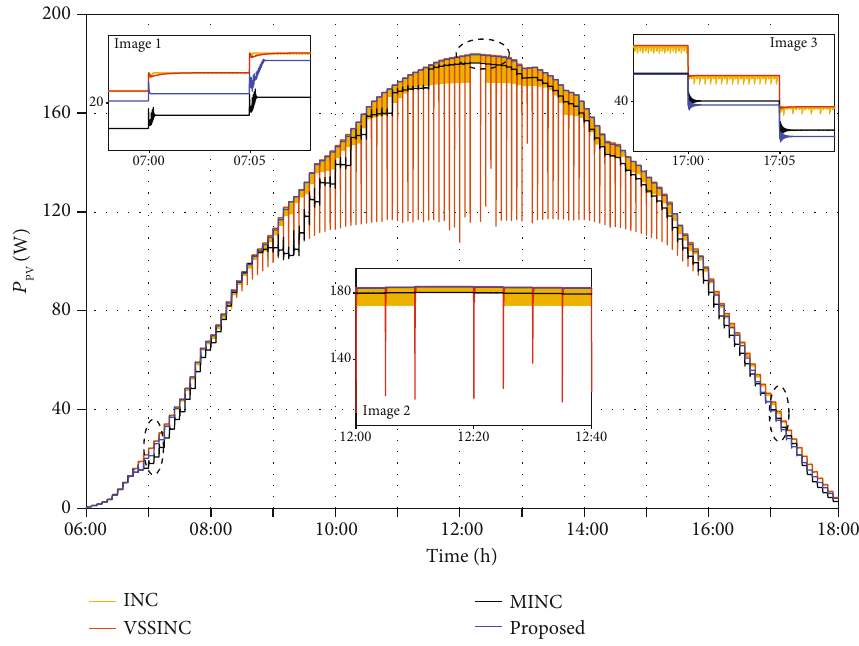
Figure 14: Power waveforms of the INC, VSSINC, MINC, and the proposed technique.